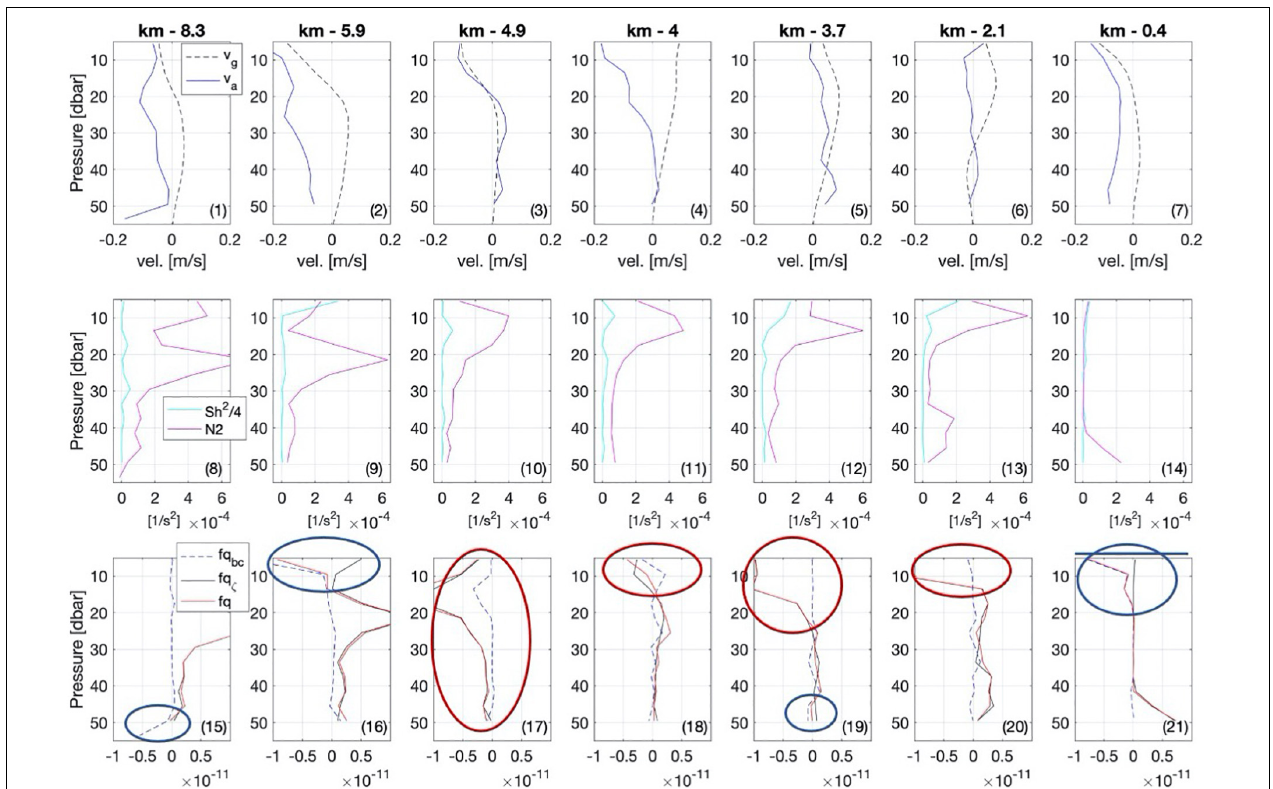
FIGURE 5 | Selected profiles of the (1–7) geostrophic v g and observed along-front velocity v a , (8–14) stratification N 2 and total Sh 2 / 4, for easier comparison with the critical Richardson number (Ri = 1/4 or, equivalently, N 2 = Sh 2 / 4). (15–21) The vertical ( fq ζ ), baroclinic ( fq bc ), and total potential vorticity ( fq )component. The locations of the single profiles used here, are marked in Figure 4 with a black dot at 53 m and a blue